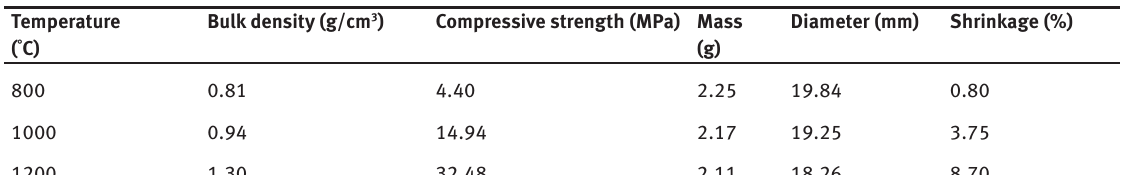
Table 4: Physical-mechanical properties of cylinders of raw trepel compared to the sintered samples at 800, 1000 and 1200°C for a period of 60